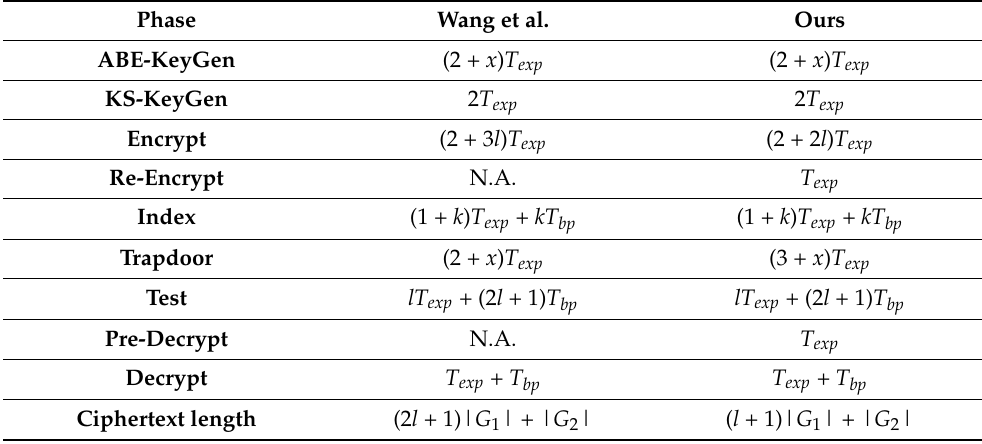
Table 3. Comparison of computational costs.